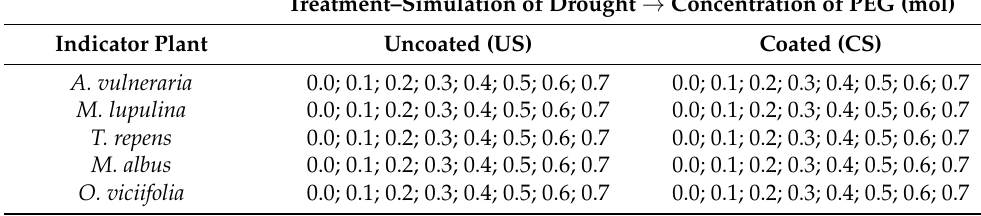
Table 3. Overview of laboratory experiment. Treatment–Simulation of Drought → Concentration of PEG